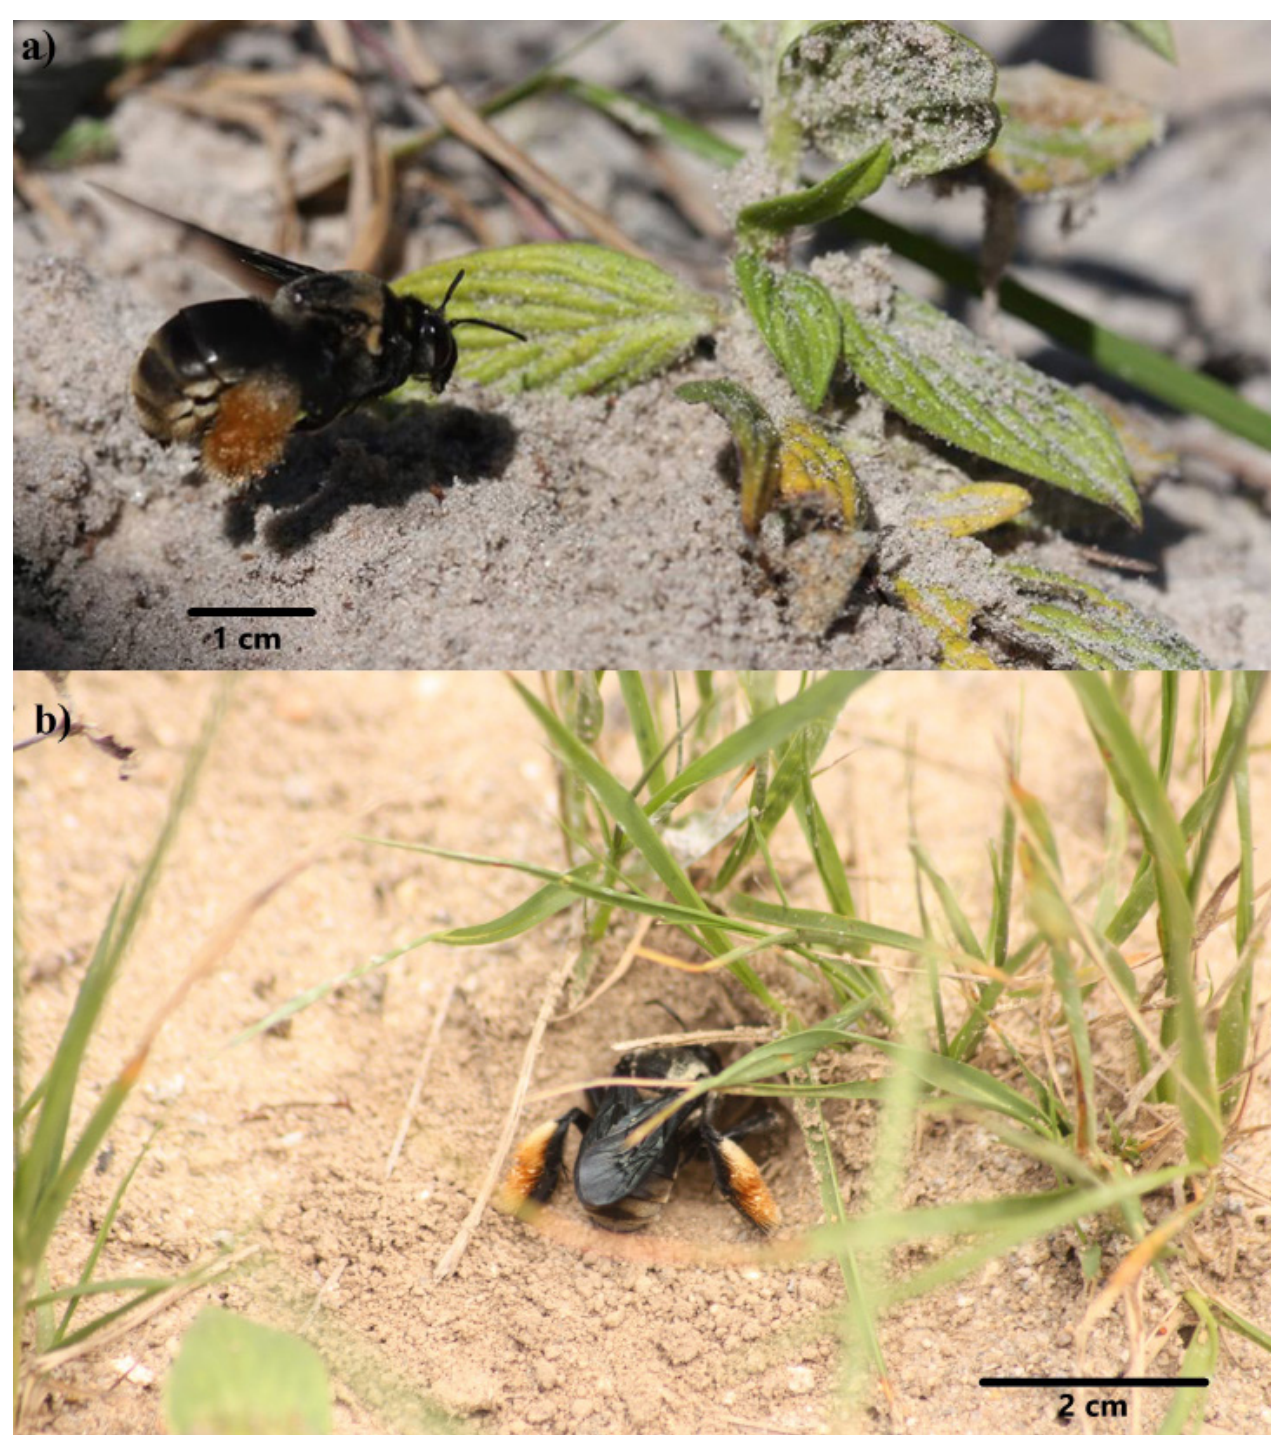
Figure S1. (a) Detail of a female of Epicharis dejeanii flying over the ground at a height of approximately 2 cm; (b) on the ground, beginning the construction of the